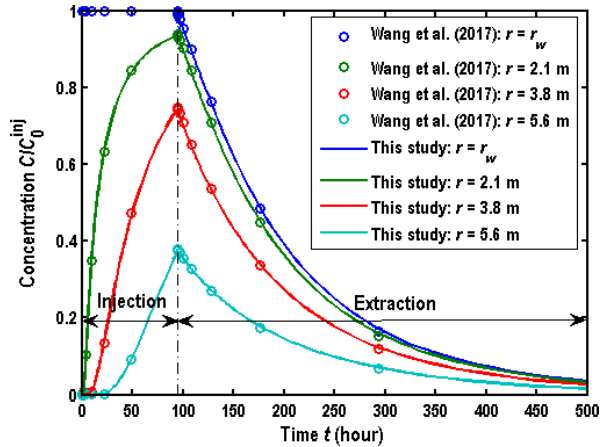
Figure 2. Comparison of BTCs between the solutions of Wang et al. (2017) and of this study, where C inj of the prepared solute in the injection